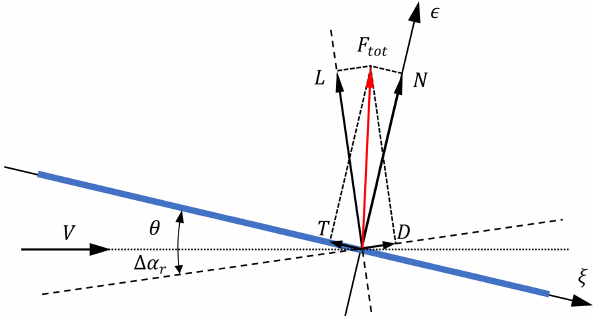
Figure 2. Projection of the normal and tangential forces ( N and T ) to the lift and drag forces ( L and D ) that are defined according to a flow direction that has an angle of (cid:49)α r from the geometric flow direction. The choice of the reference direction, which consequently defines lift and drag, could be arbitrary as long as the same total force F tot is